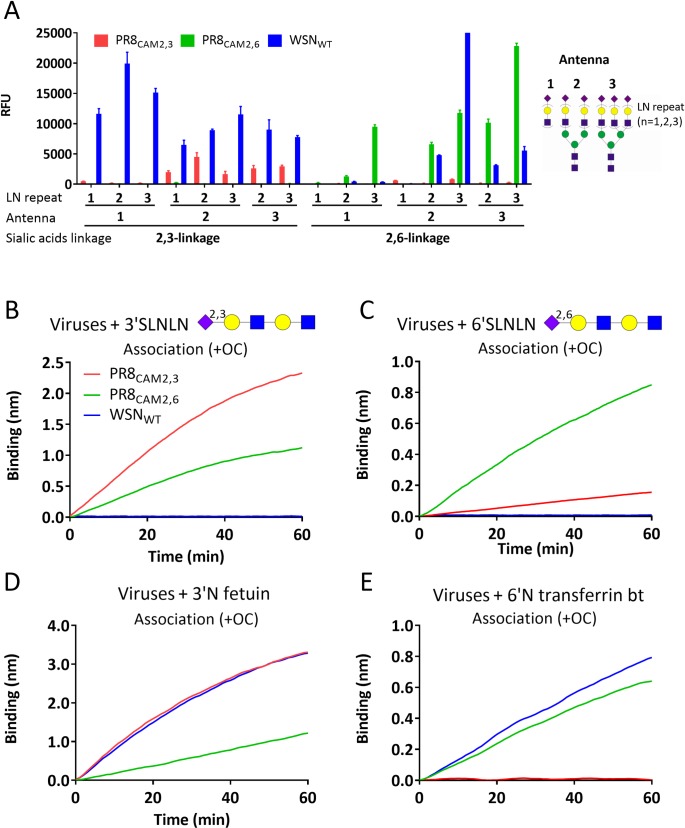
Quantification of virus binding specificity by BLI.(A) Specificity of recombinant soluble HA trimers of PR8CAM2,3, PR8CAM2,6 or WSNWT was determined by glycan array analysis. Binding to mono-, bi- and tri-antennary glycans carrying one, two or three LacNAc repeats terminated with a α2,3- or α2,6-linked SIA is indicated. Means of 6 independent replicates are graphed, standard errors of the means are indicated. Biotinylated 3’SLNLN or 6’SLNLN (B, C), Fc-tagged 3’N fetuin (D) or biotinylated 6’N transferrin (6’N transferrin bt) (E) were loaded to maximum levels to SA or Protein A biosensors after which binding of 100 pM PR8CAM2,3, PR8CAM2,6 or WSNWT virus was monitored for 60 minutes in the presence of 10 μM OC.